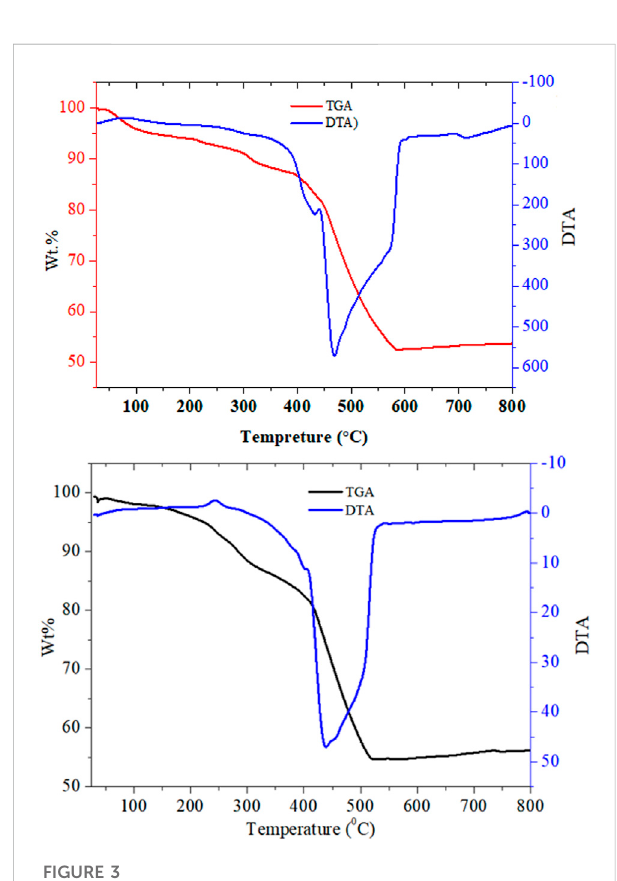
FIGURE 3 TGA/DTA graphical presentations of the Cr1 (top) and Cr2 (bottom)